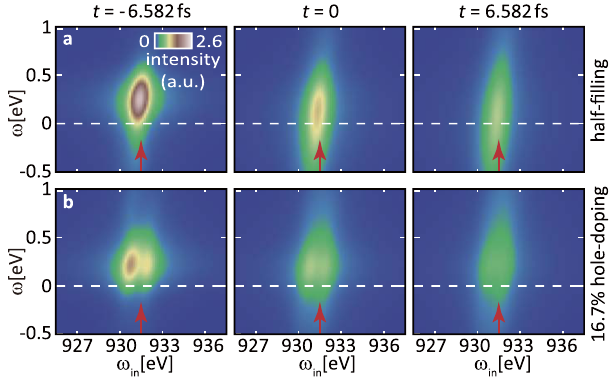
Fig. 2 Snapshots of the time-resolved resonant inelastic X-ray scattering signal. Cross-polarized time-resolved resonant inelastic X-ray scattering (trRIXS) spectra for selected pump – probe time delays as a function of the incident photon energy ω in for a x = 0 and b x = 0.167 hole doping. ω = ω − ω in s indicates the energy loss, while the momentum transfer is kept fi xed at q = ( π /2, π /2). The peak at ω ~ 0.3 eV corresponds to the collective spin fl uctuations of the system. The red arrow marks the center of mass of the resonance along the ω in axis. The color bar indicates the spectral intensity in arbitrary units